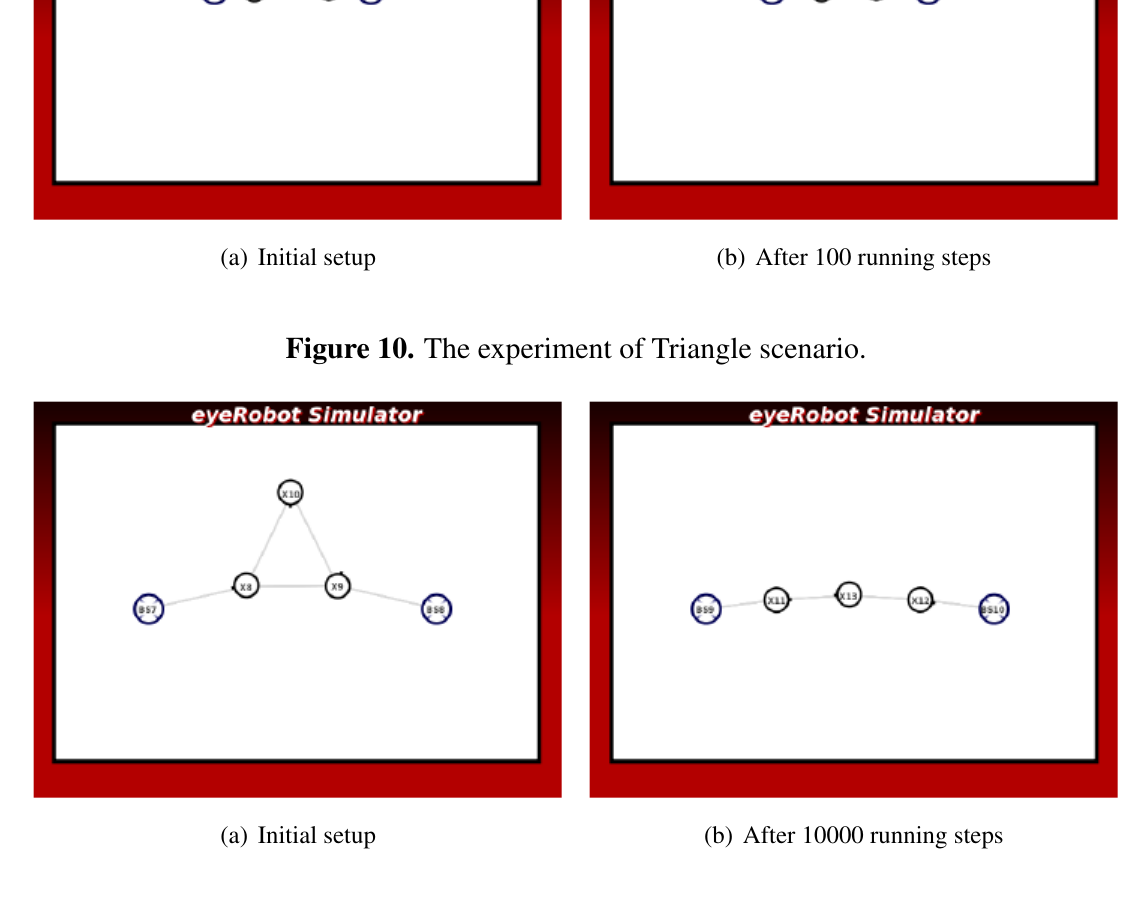
Figure 11. The experiment of the Kite